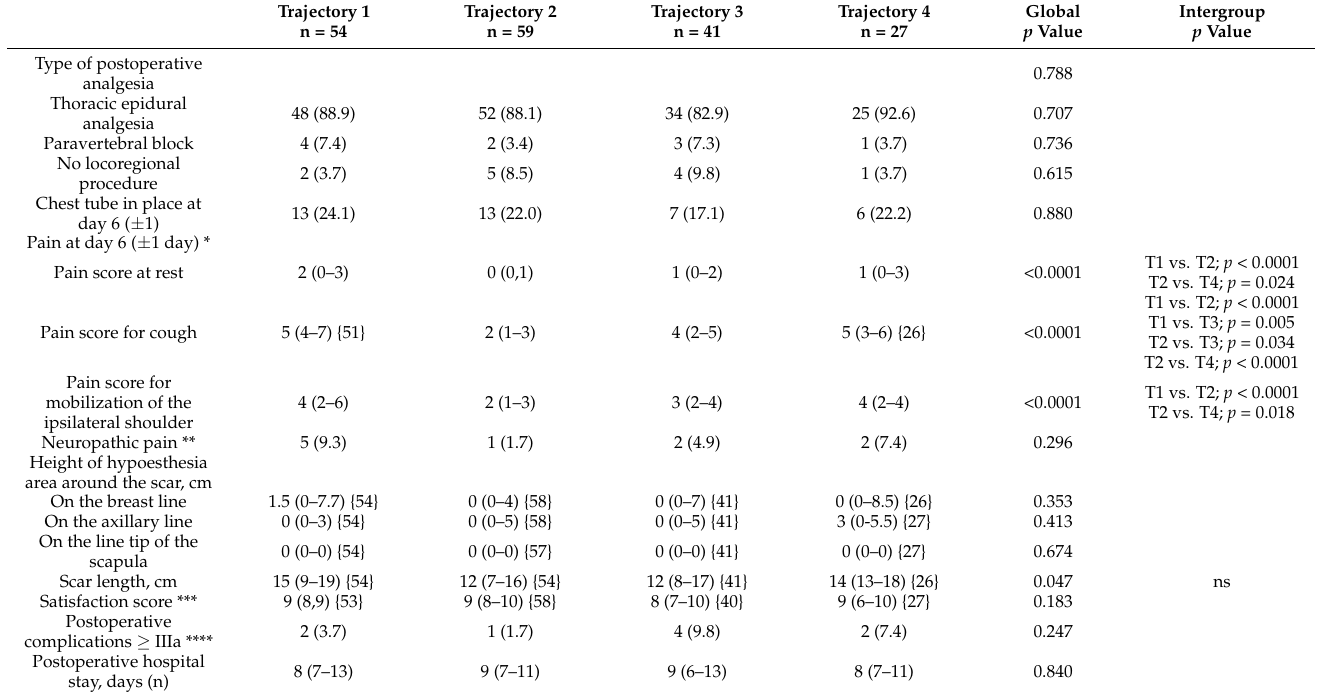
Table 6. Postoperative hospital stay variables for each trajectory